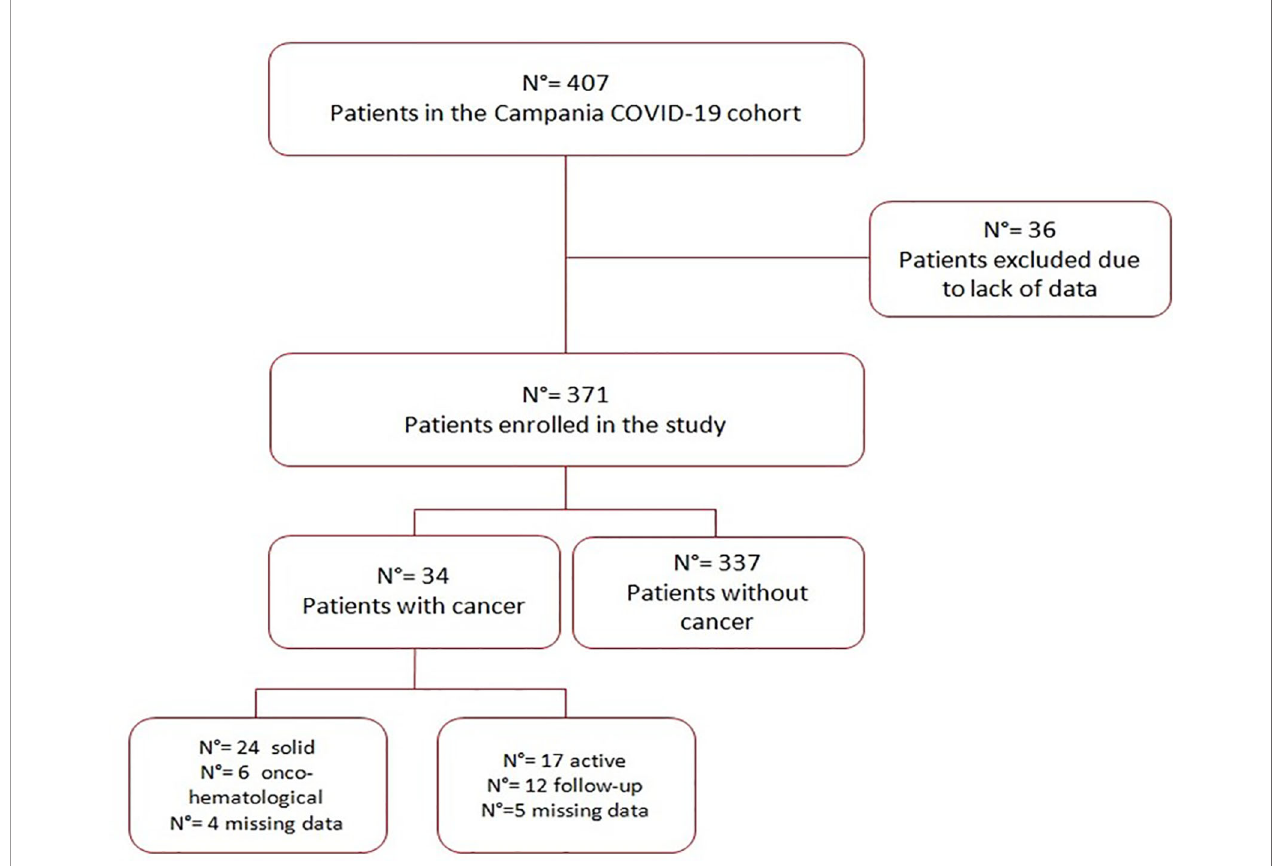
FIGURE 1 | Study population fl